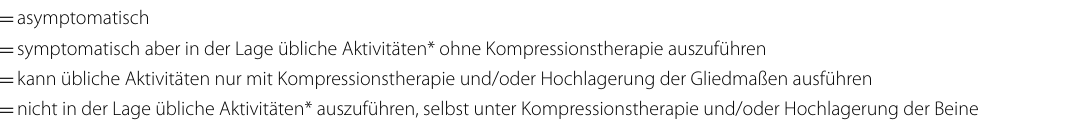
Table 2 German version of the venous disability score used in pre-testing